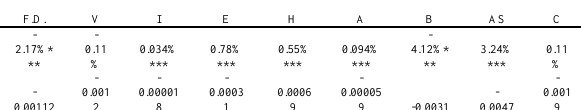
Table 3. Determinants of buying vegetables at a full-service grocery store